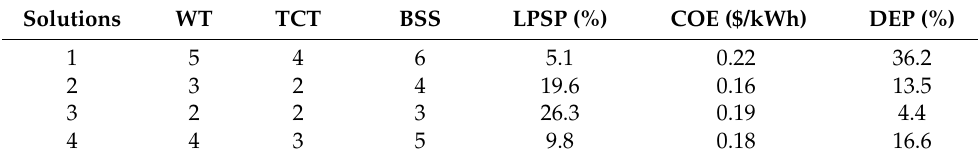
Table 4. Optimal solutions of each objective and the optimal equilibrium solution.